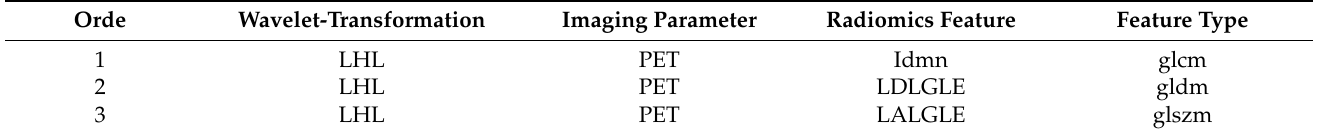
Table 3. Radiomics features from Lasso regression analysis.